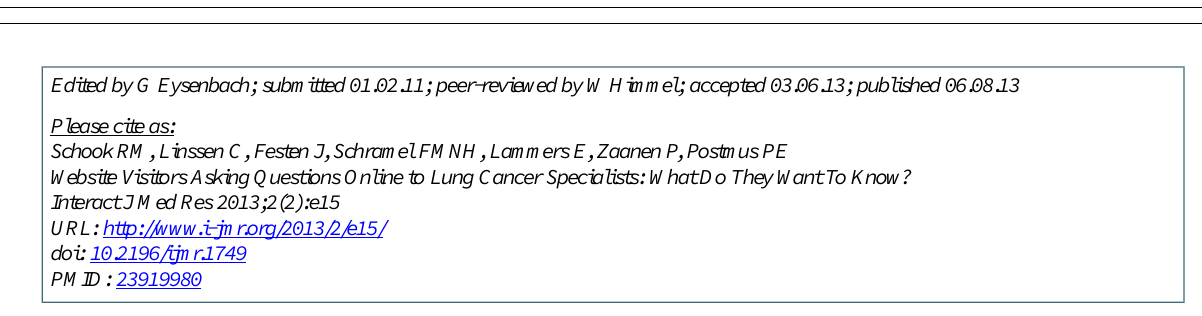
DLIC: Dutch Lung Cancer Information